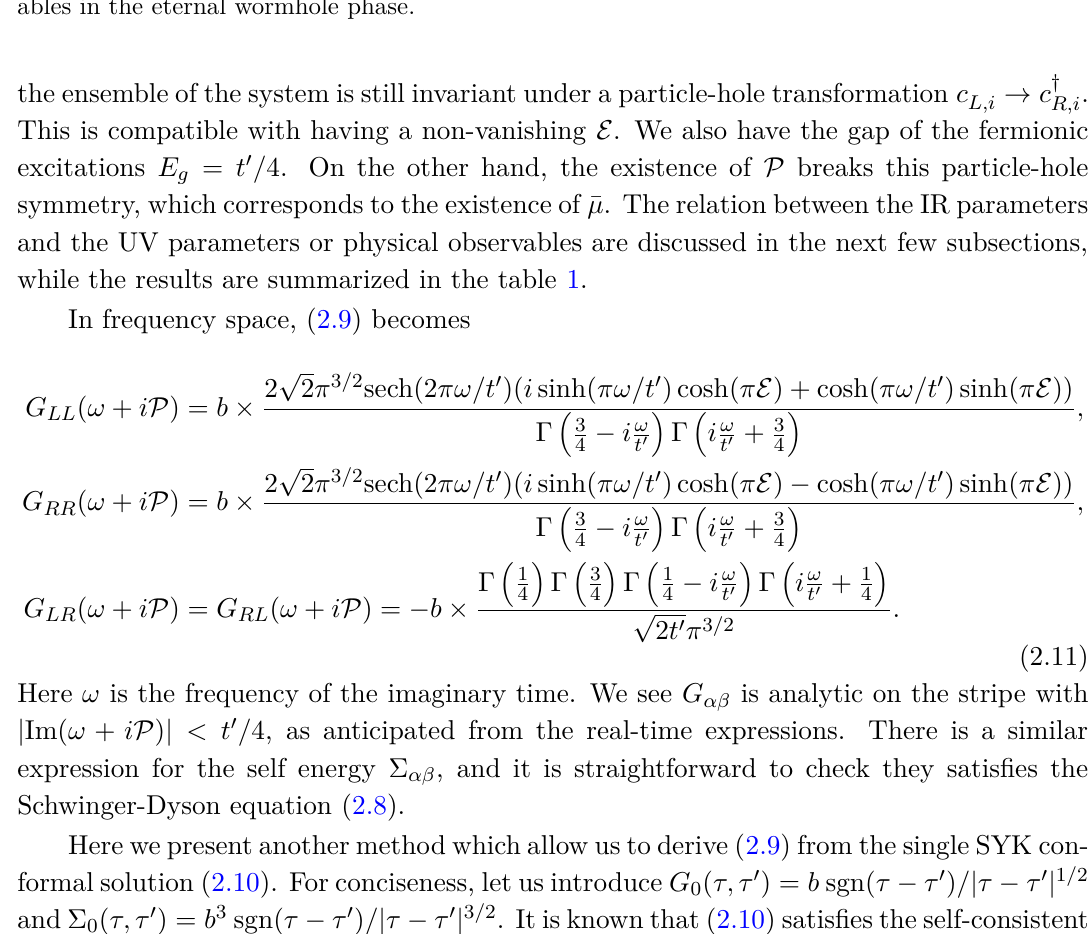
Table 1 . A summary of relations between the IR parameters and UV parameters/physical observ- ables in the eternal wormhole